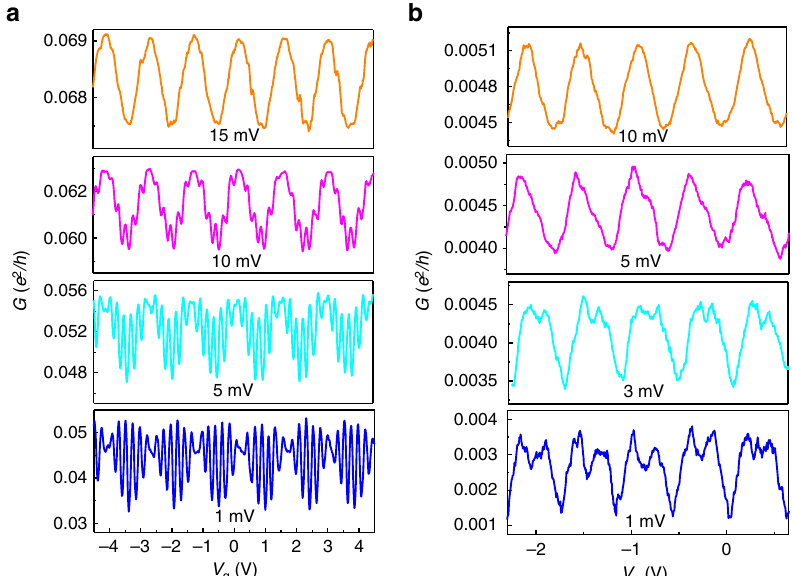
Fig. 4 Effect of bias voltage on the multiple-periodicity. G ( V g ) for two different dots at different values of bias voltage. For both dots, at V SD = 1 mV two dominant periods are clearly observed. For higher values of bias voltage ( V SD > 10 mV) a period corresponding to the base P CB is dominant. a The dot is characterized by η = 4.7 ± 0.1. The ratio between the two dominant periods is 6. b The dot is characterized by η = 3.4 ± 0.1. The ratio between the two periods is 2